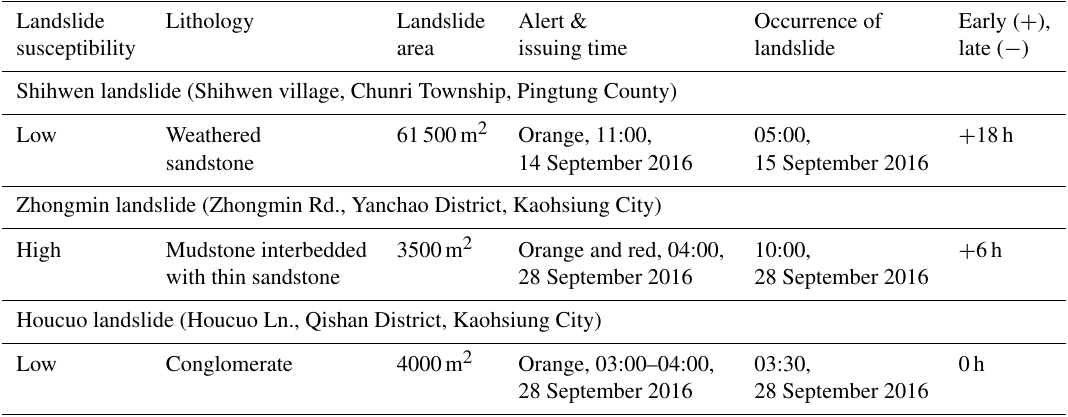
Table 9. Disastrous landslide cases in 2016 and the results of validation. Warnings could have been issued for all landslide cases in advance or at the time of occurrence (all times referred to are in UTC+8).